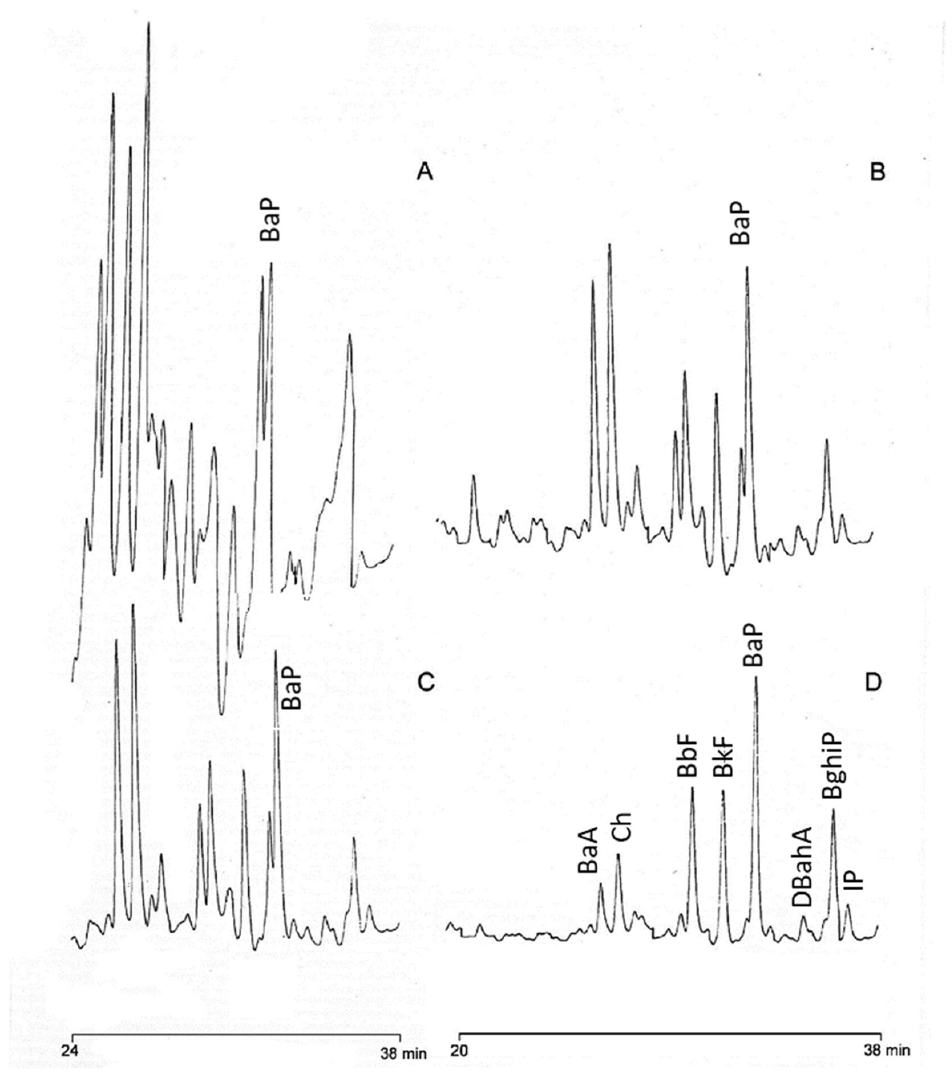
Figure 2. HPLC-FLD chromatograms of the same sample of crude pomace oil purified by following procedure proposed by ( A ) Moret and Conte (2002) [34], ( B ) by Moreda et al. (2004) [35], ( C ) by using the new proposed approach, and ( D ) by using the new proposed approach but reducing the elution